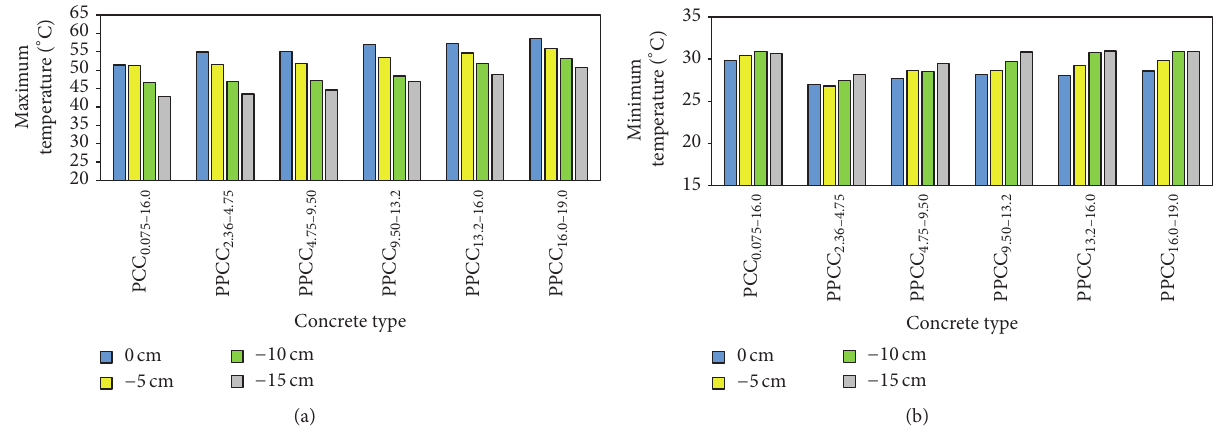
Figure 6: Maximum temperature and minimum temperature of different concrete: (a) maximum temperature in the daytime; (b) minimum temperature in the nighttime.